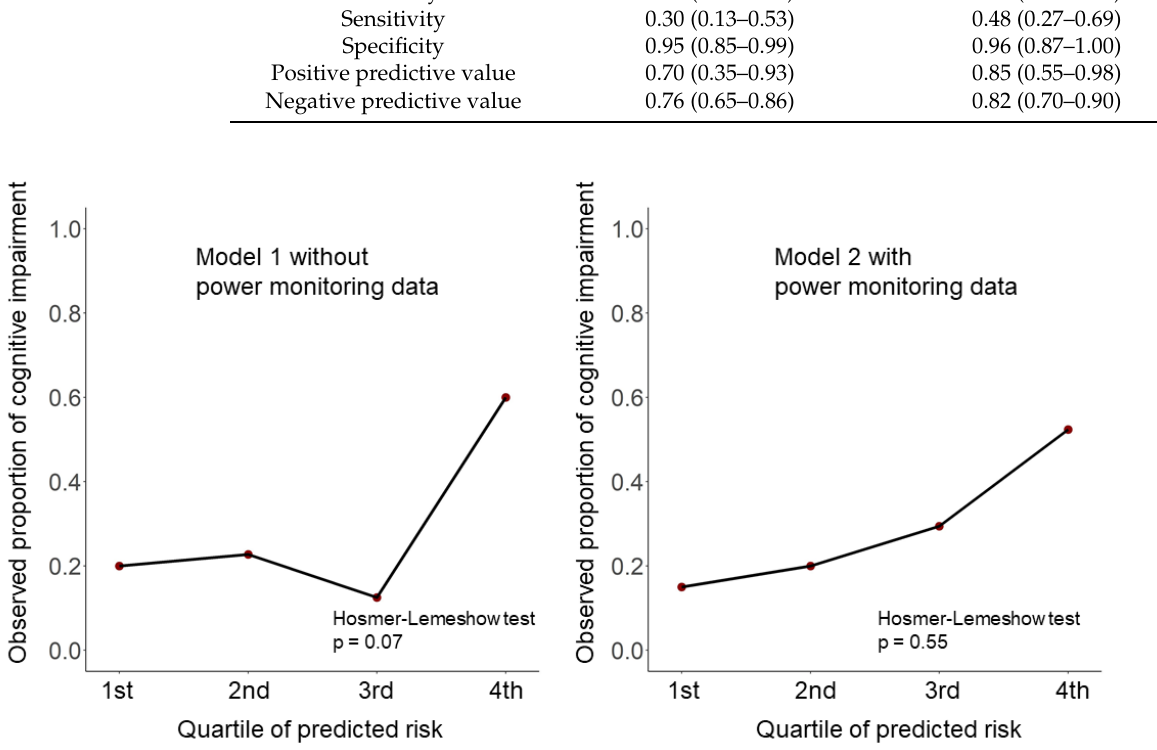
Figure 4. Calibration plots and Hosmer–Lemeshow test values for the two prediction models.